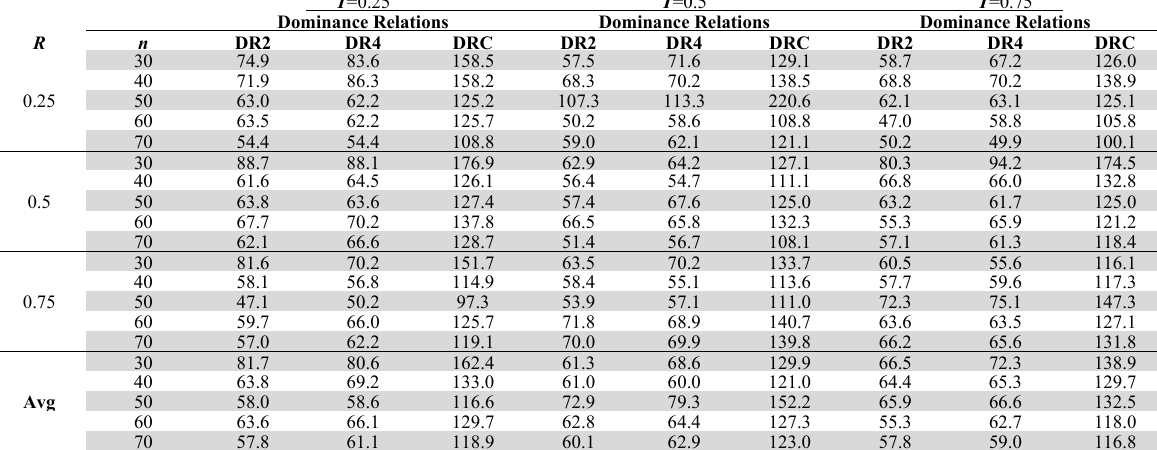
Percentage Improvement of Dominance Relations ( Δ = 10) T =0.25 T =0.5